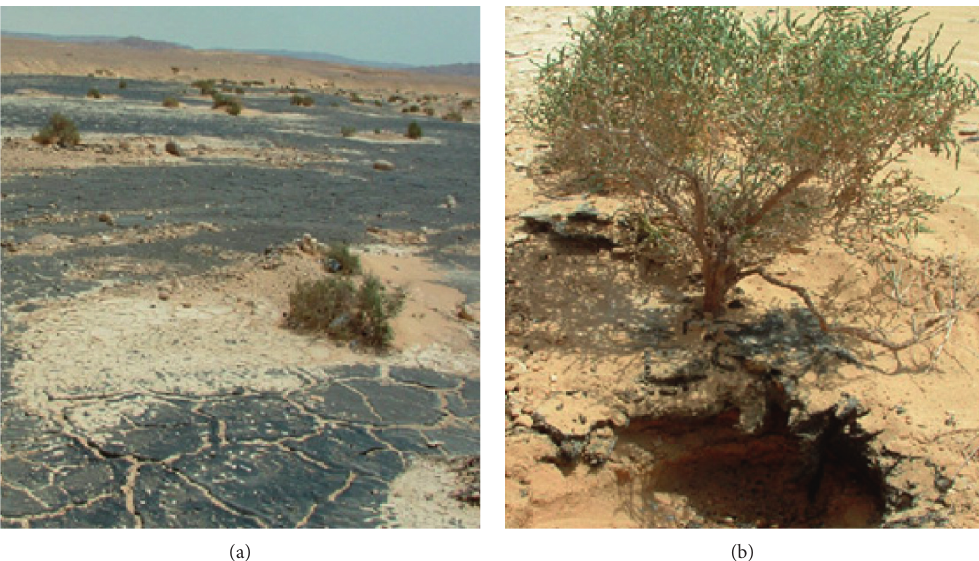
Figure 1: Soil polluted with petroleum oil as a result of accidental cracking of petrol pipelines. Soil samples, for isolation of potent petroleum-degrading fungi, have been assembled from open polluted areas (a) and from the rhizosphere of survived desert vegetation